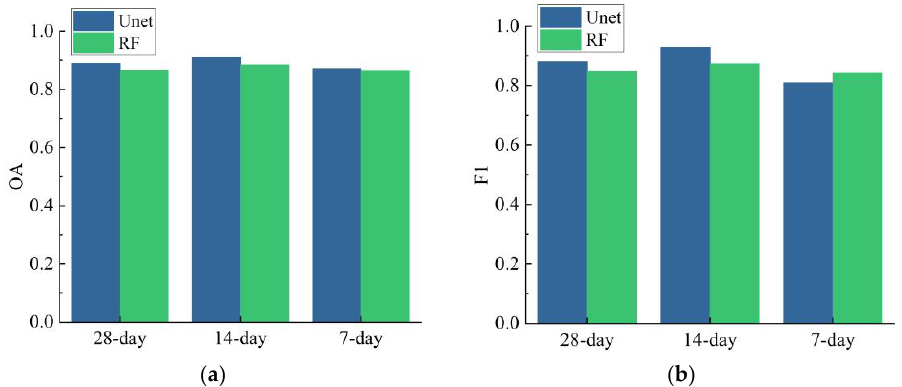
Figure 6. Rice extraction results of test area in 2020 for U-net and Random Forest classifiers with different time interval scenarios. ( a ) Overall accuracy; ( b ) F1